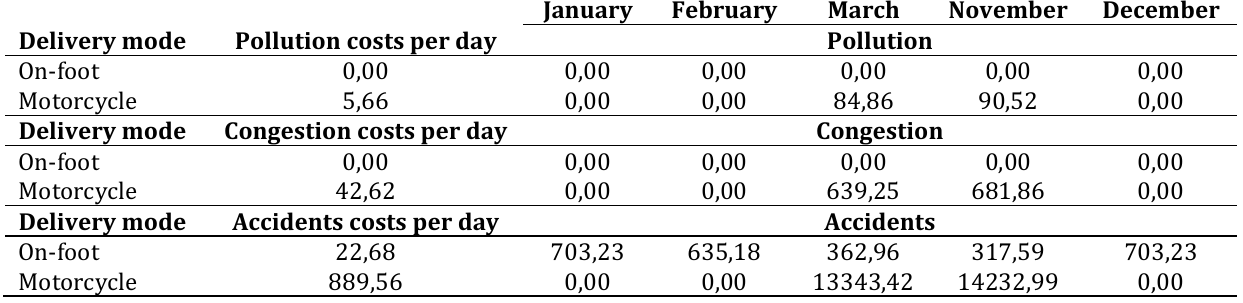
Table 13: External costs of combination “On-foot+Bicycle” for season with difficult weather conditions Delivery